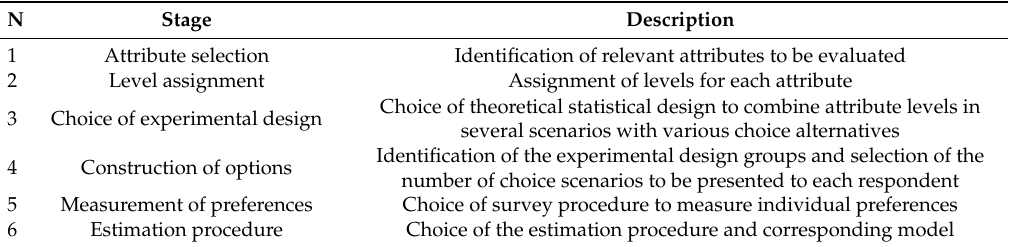
Table 1. Stages of the choice experiment methodology.